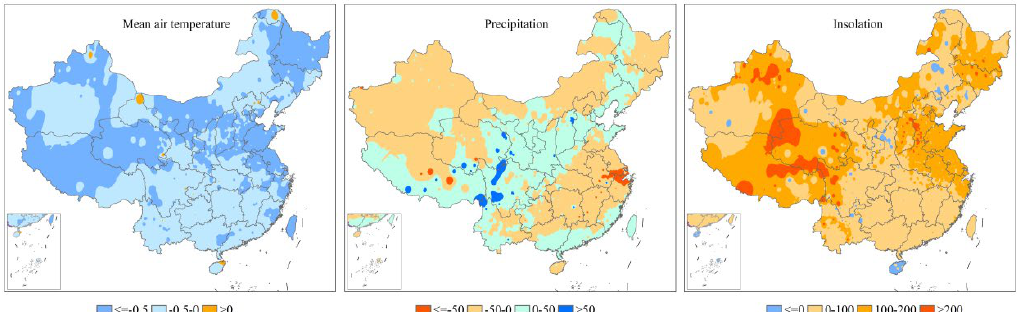
Figure 10. Difference between the change in factors (mean air temperature, precipitation, and inso-